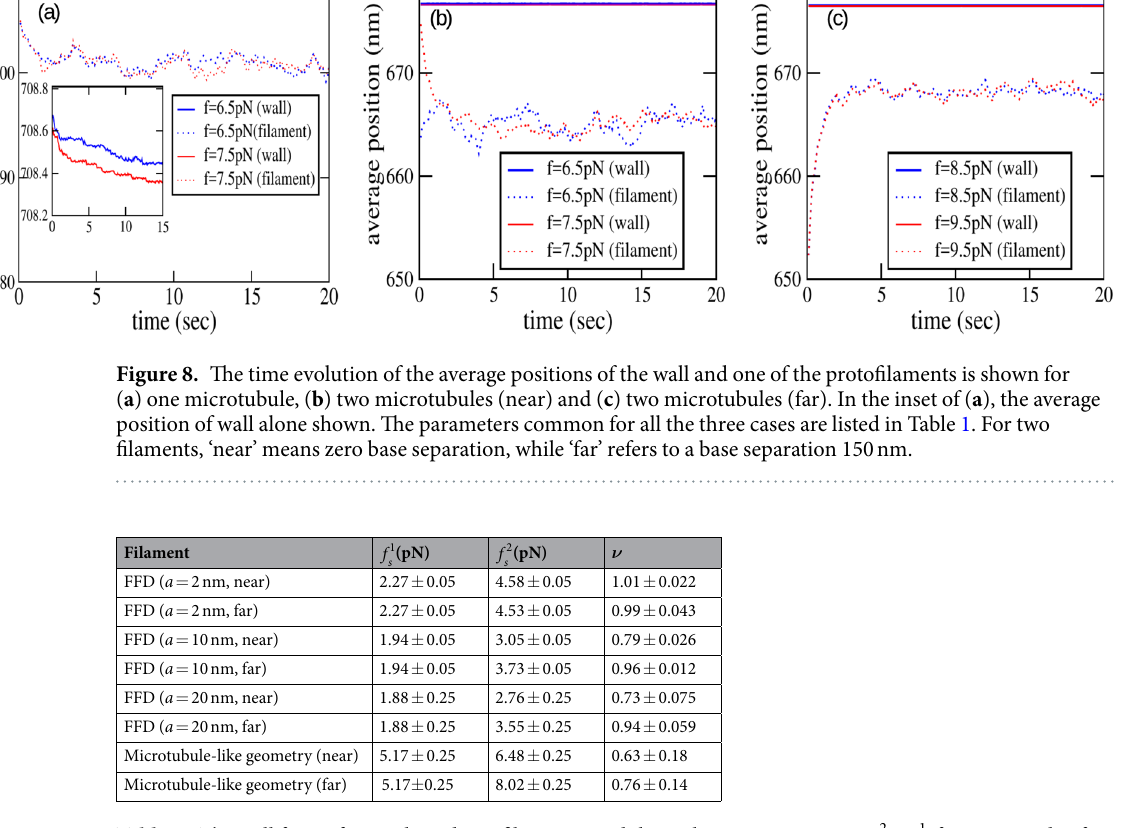
Table 2. The stall forces for single and two filaments, and the scaling parameter ν = f 1 , for N = 1 and 2, for flat-faced disc polymers and microtubule-like polymers. The deviation from unity indicates sublinear scaling with N . The error bar in the stall force data is estimated as half of the step size for force used in the simulations. For two filaments, ‘near’ refers to zero base separation and ‘far’ refers to base separation 10 times the radius of cross-section (except for the last, where the base separation is 150